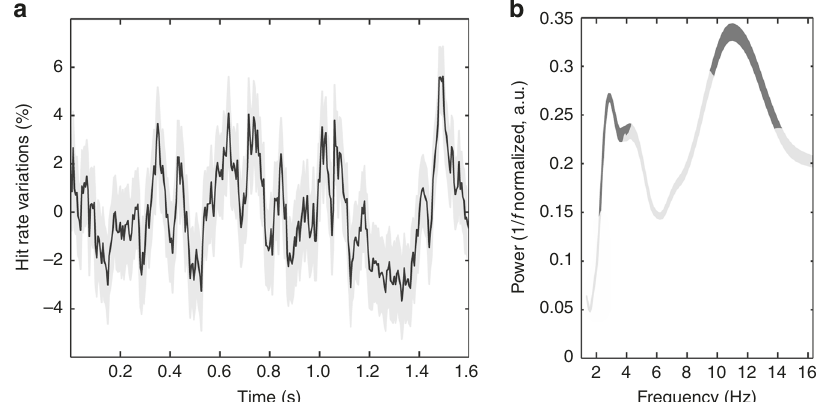
Fig. 5 Oscillations in cumulated behavioral performance. a Changes in hit rates (detrended mean + / − s.e.) as a function of time of target presentation relative to cue presentation. Behavioral data compiled across all recording sessions and both monkeys. b Behavioral time series power spectrum (mean + / − s.e.). Frequencies signi fi cantly modulating overall behavioral performance in dark gray (95% CI on random permutation of target